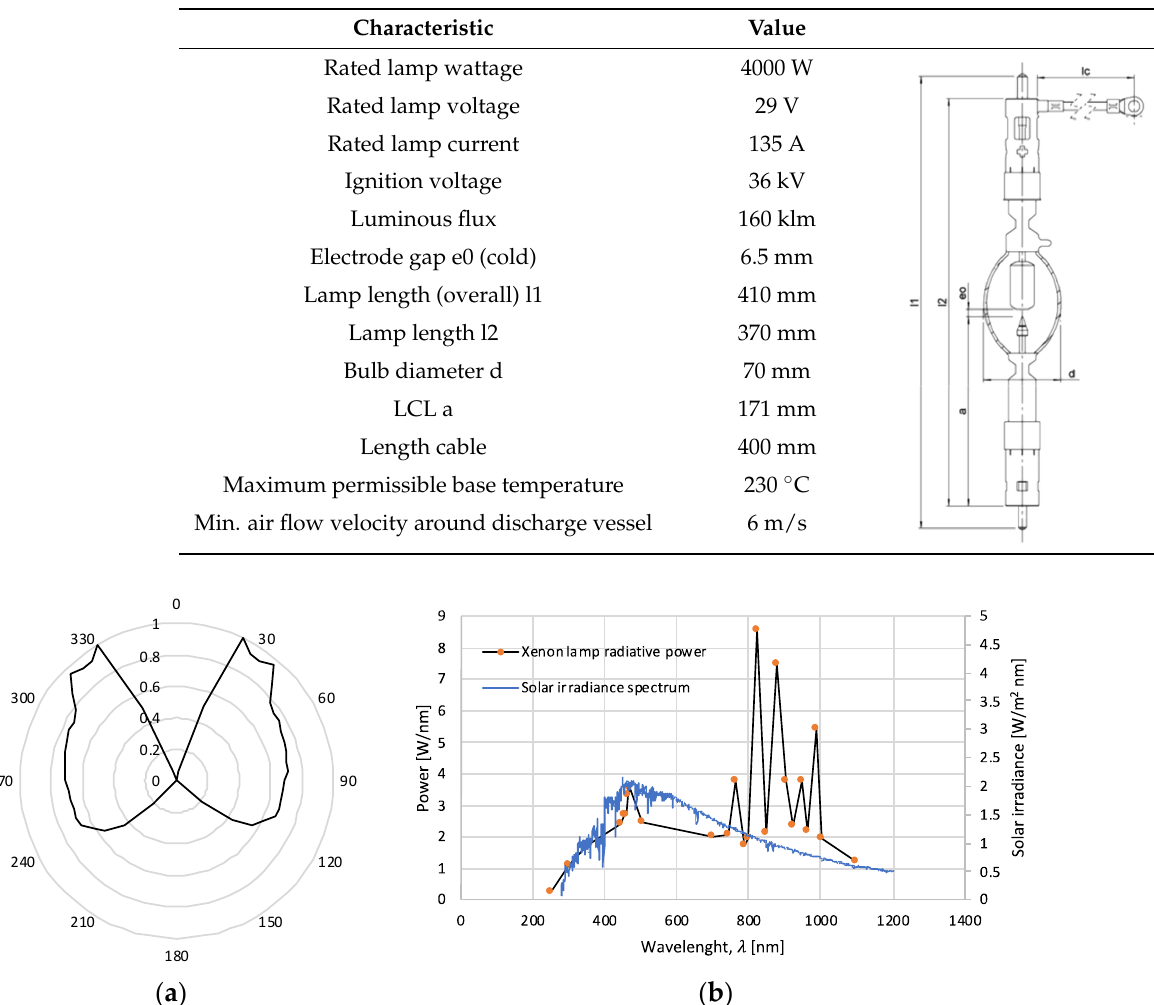
Table 1. Main characteristics of OSRAM XBO 4000 W/HSA OFR Xenon short arc lamp.